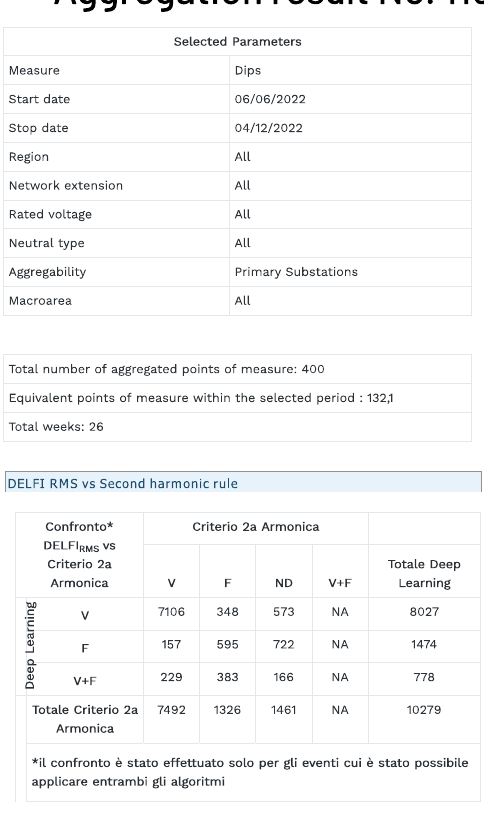
Figure 27. QuEEN website table: validity criteria online comparison.